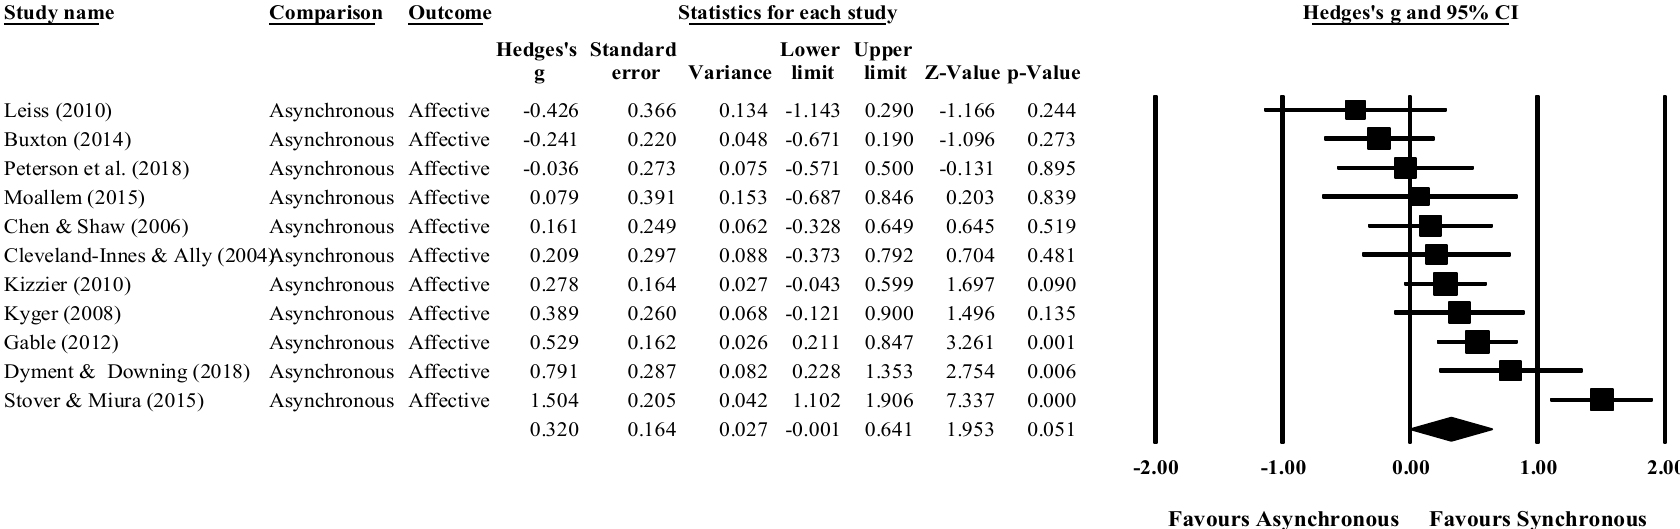
Figure 5 Forest Plot of Affective Outcomes (Synchronous vs.